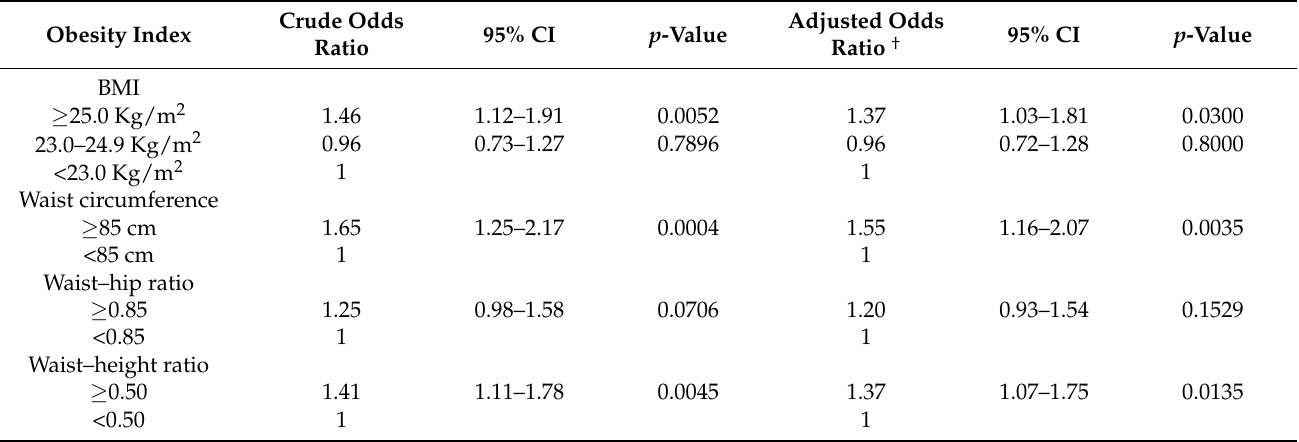
Table 2. Association between obesity indices and thyroid cancer risk.